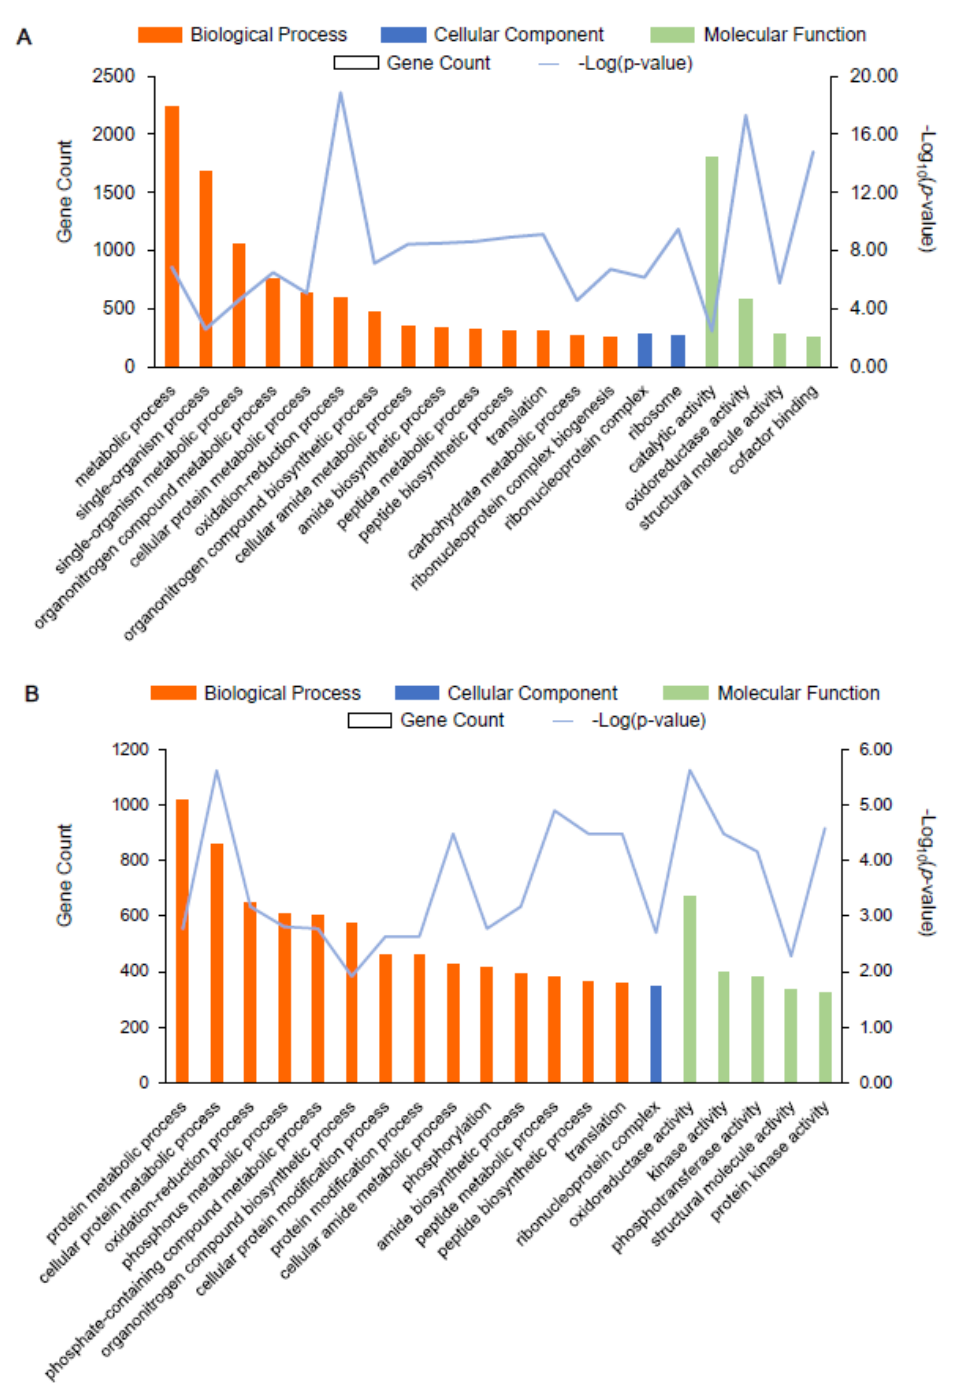
Figure 8. GO enrichment analysis of the top 20 most strongly represented categories. Note: the degree of GO enrichment is represented by the –log10 ( p -value) (line chart) and the amount of DEG (column chart) enrichment in each category. ( A ) represents AR1018r vs. AR1031r, and ( B ) represents AR1018y vs. AR1031y.